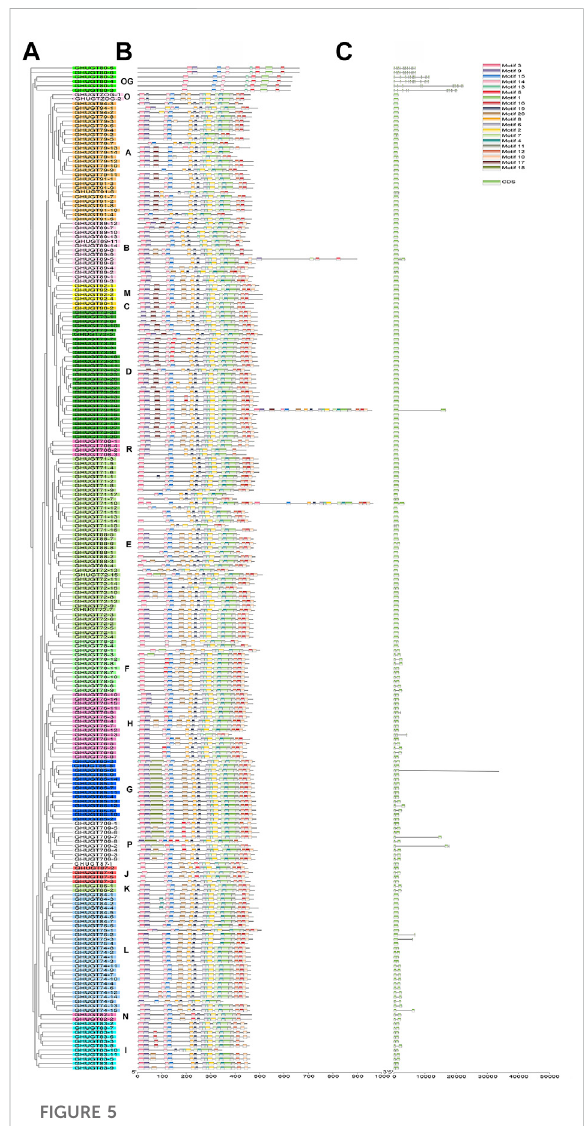
FIGURE 5 Phylogenetic tree, motifs and exon/intron structures of GHUGTs in G. hirsutum . (A) Phylogenetic tree of GHUGTs . (B) Conserved motifs of GHUGT proteins. (C) Exon/intron structures of GHUGTs